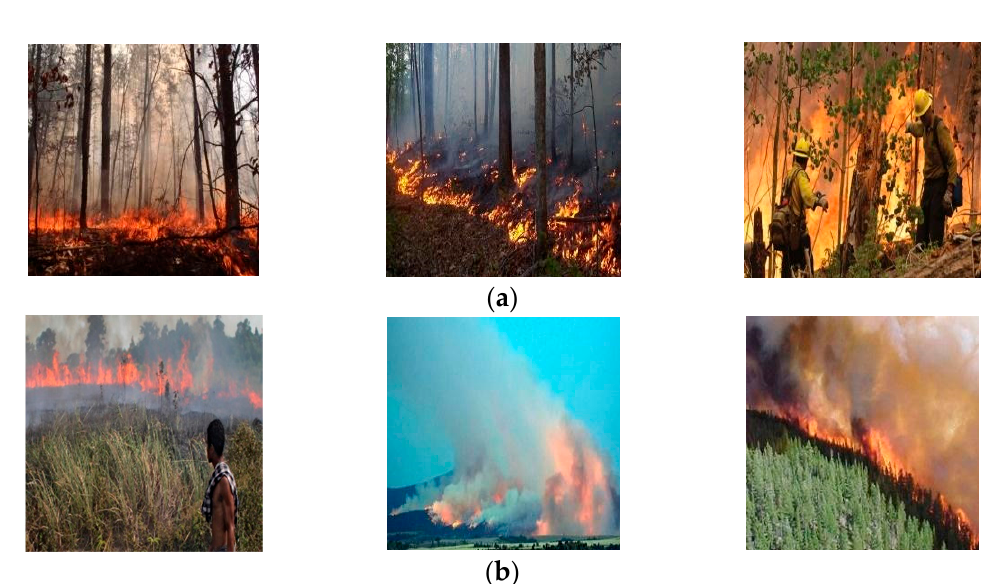
Figure 6. Fire images with different shapes ( a ) close by and ( b ) far away. ( a ) Close-distance fire images. ( b ) Long-distance fire images [6].